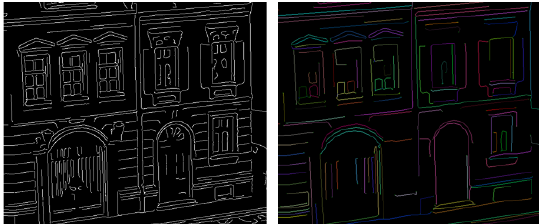
Figure 4. The dense point cloud (left), Line3D++ reconstructed 3D edges (middle) and the respective edge points (right) sampled linearly along